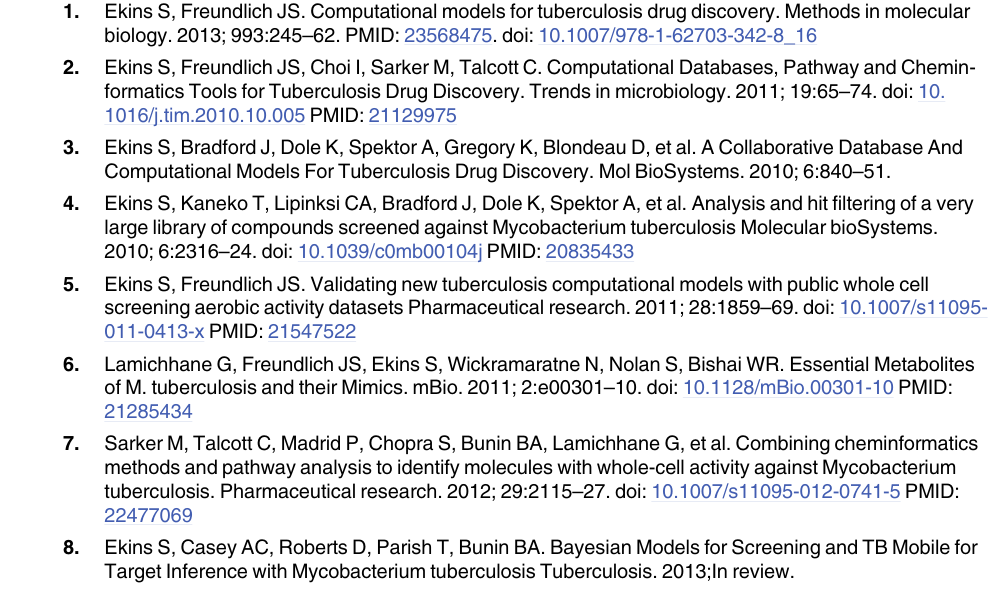
S3 Table. S154 transcriptional profiling data. S4 Table. Clustering hits with TB mobile compounds (sdf